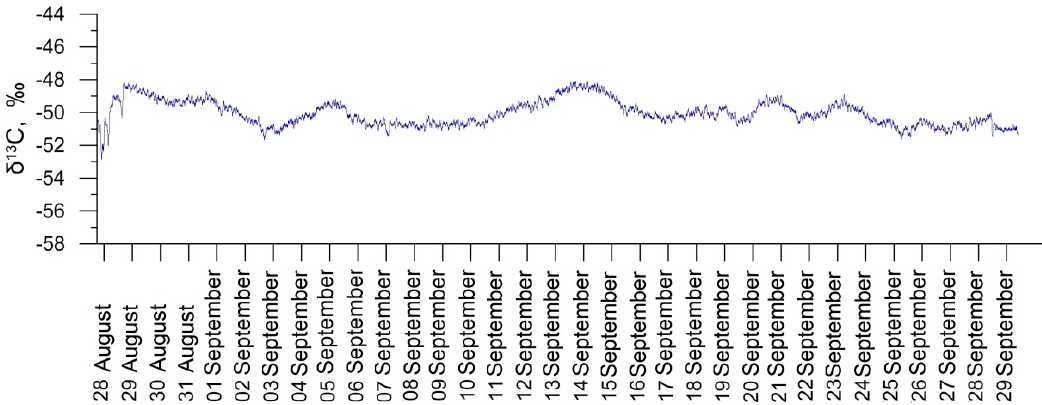
Figure 6. δ 13 C variability during AMK-83, AMK-84, and AMK-85 (1 h averaging). The Keeling plot method was used for more accurate analysis of potential methane contributors [46–48]. The largest possible range of mixing ratios of CH 4 in the air mass is required to ensure maximum accuracy in determining the isotopic characterization of excess methane in the air mass. The difficulty in identifying sources during ship-borne measurements is that the air flow is not uniform and accumulates methane from several sources while passing over different areas. Figure 7 shows examples of Keeling plots.